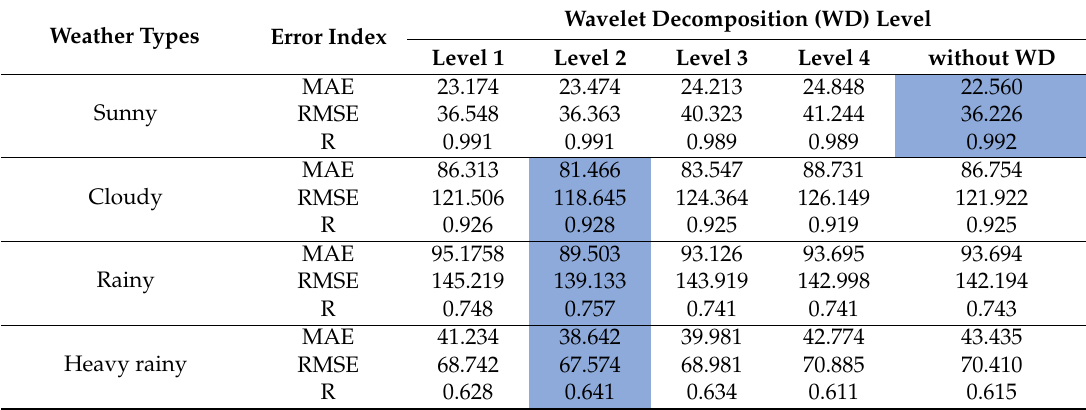
Table 5. The performance comparison of DWT-CNN-LSTM model at different WD levels using the dataset of Elizabeth City State